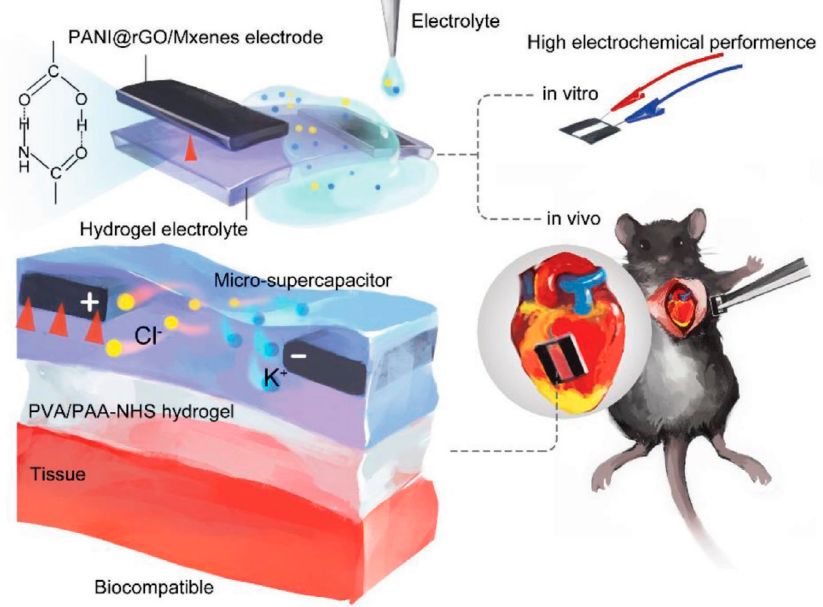
Figure 8. Schematic illustration of the fabrication process and implantation of micro-supercapacitor onto the heart of living mice. Reprinted with permission from [90]. Copyright 2021, Wiley Online Library.